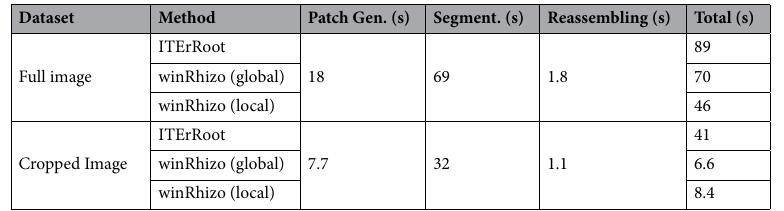
Table 8. Timing results for ITErRoot and winRhizo segementation of the hold-out cucumber datasest. Results are shown for both the Full Image and Cropped sets. Each set was segmented with ITErRoot, and winRhizo in both global and local thresholding modes. For ITErRoot, times are shown for the patch generation (Patch Gen.), Segmentation (Segment.) and patch reassembling and voting steps. All times per-image averages in seconds.